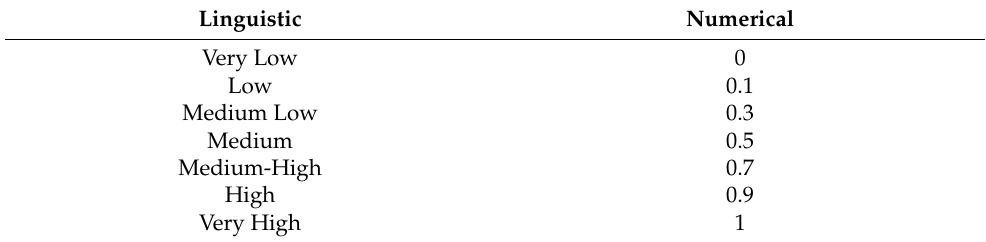
Table 6. Risk evaluation